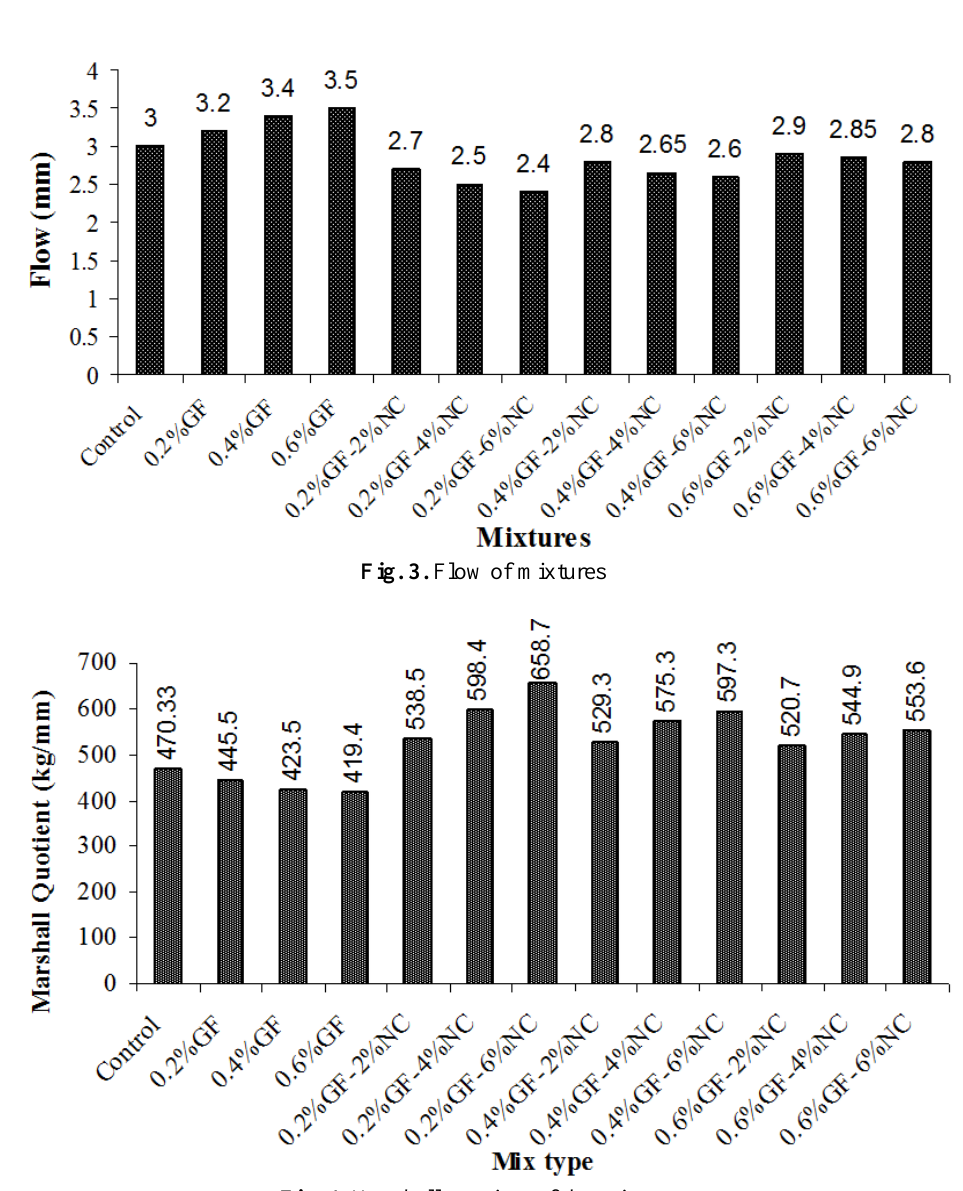
Fig. 4. Marshall quotient of the